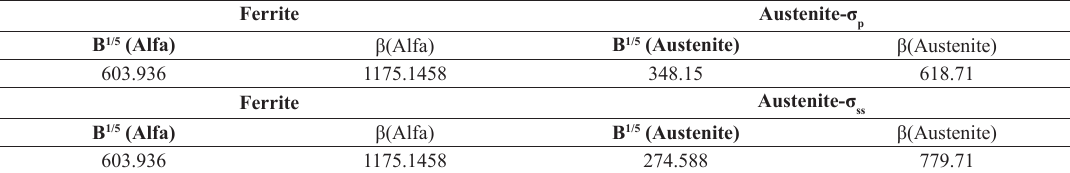
Table 5. Constants used in the generic model.